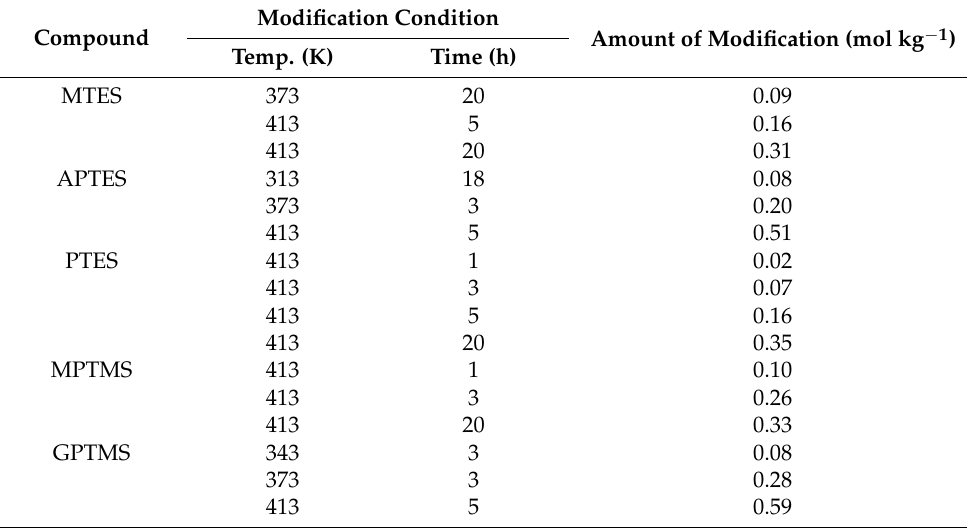
Table 1. Modification condition and modification amount of silicon